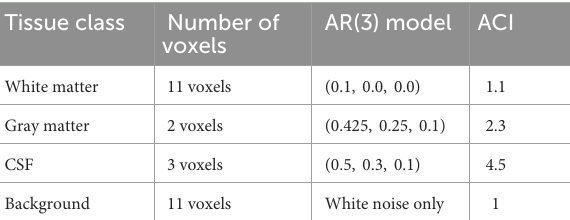
TABLE 2 Settings for the simulation study shown in Figure 7. Tissue